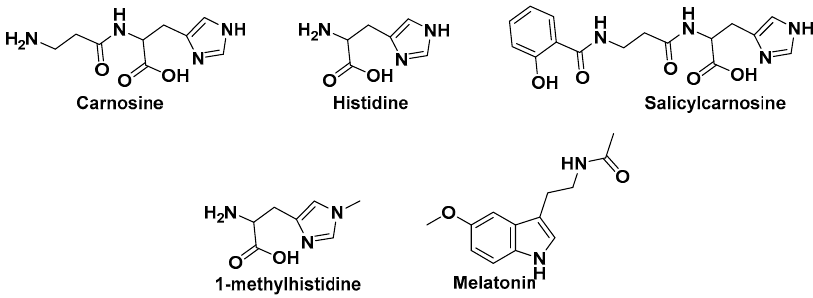
Figure 4. Chemical structures of new suggested molecules for COVID-19 treatment.